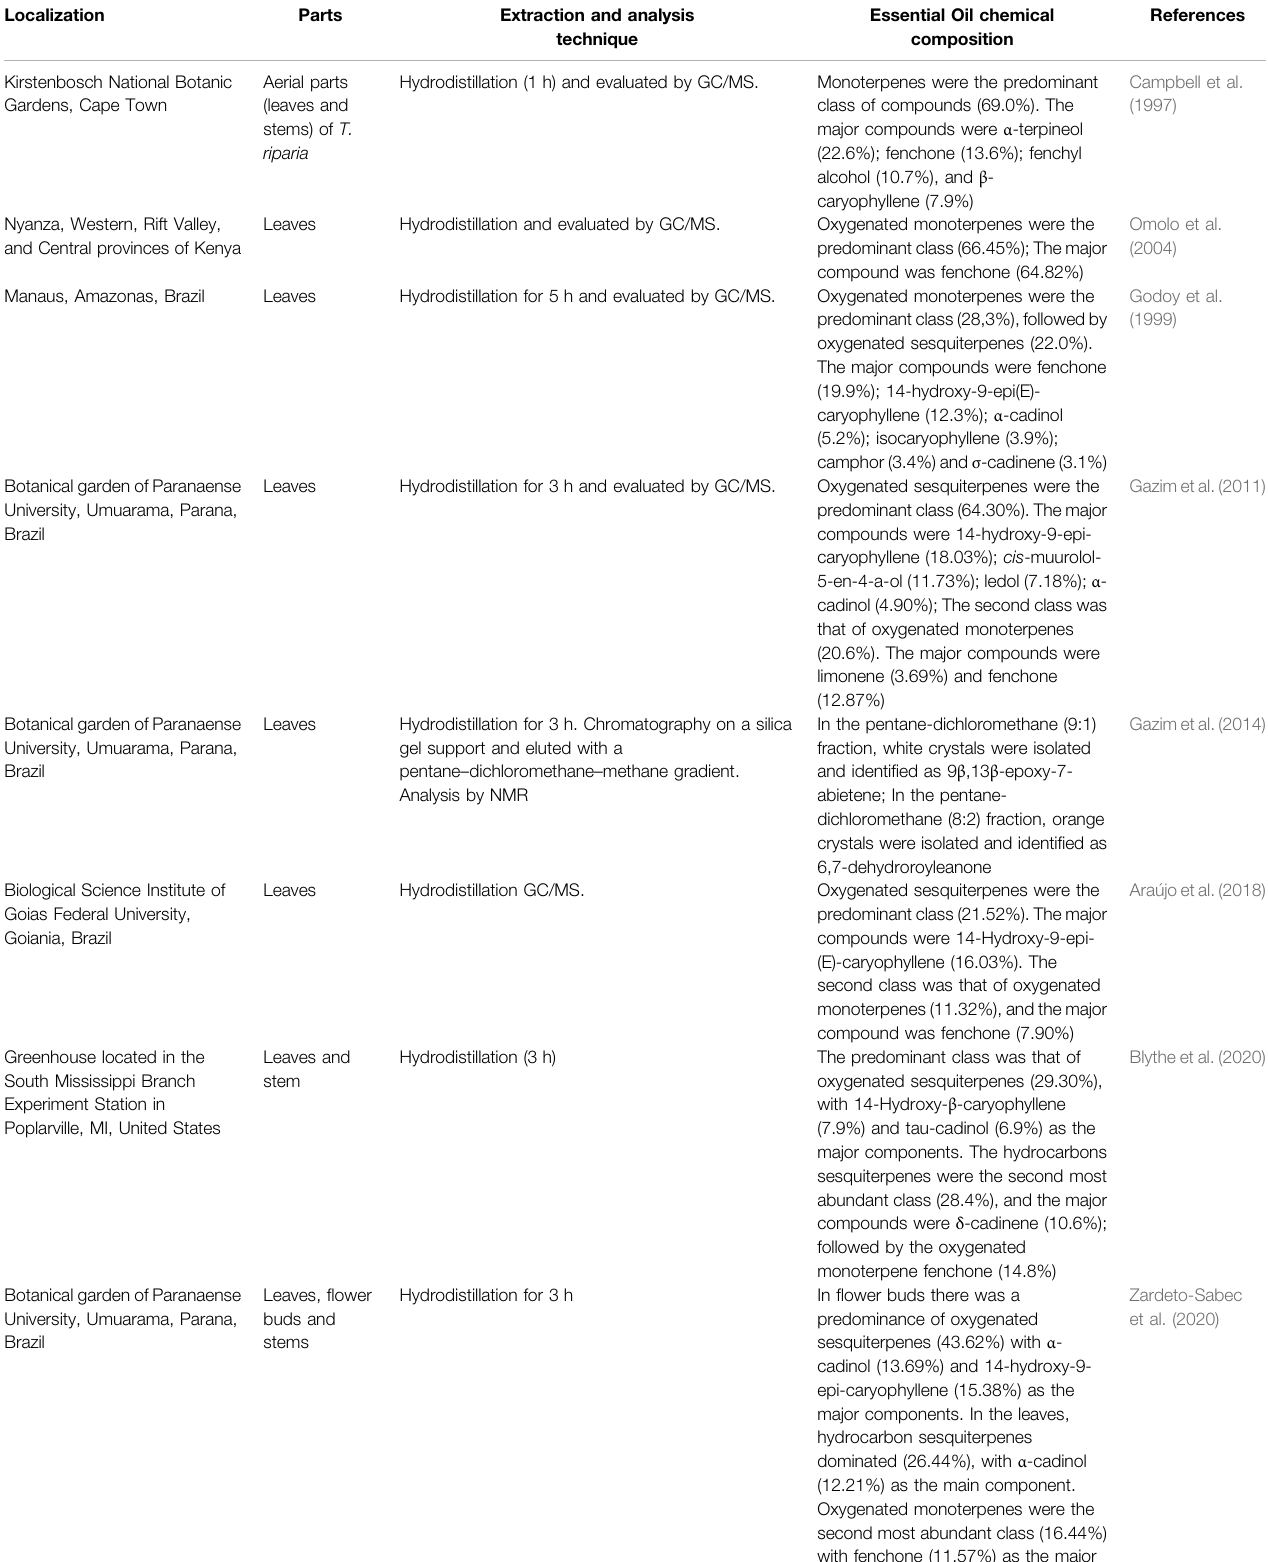
TABLE 3 | Chemical Composition of T. riparia essential